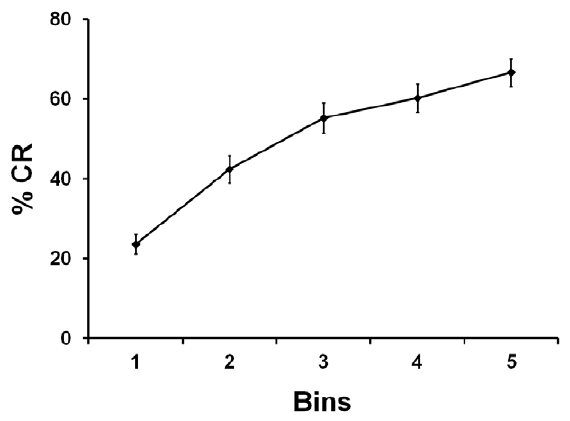
Figure 1. Learning curve for one-month-old infants. Infants learned to associate presentations of a tone with presentations of an airpuff. Error bars represent Mean 6 SEM.